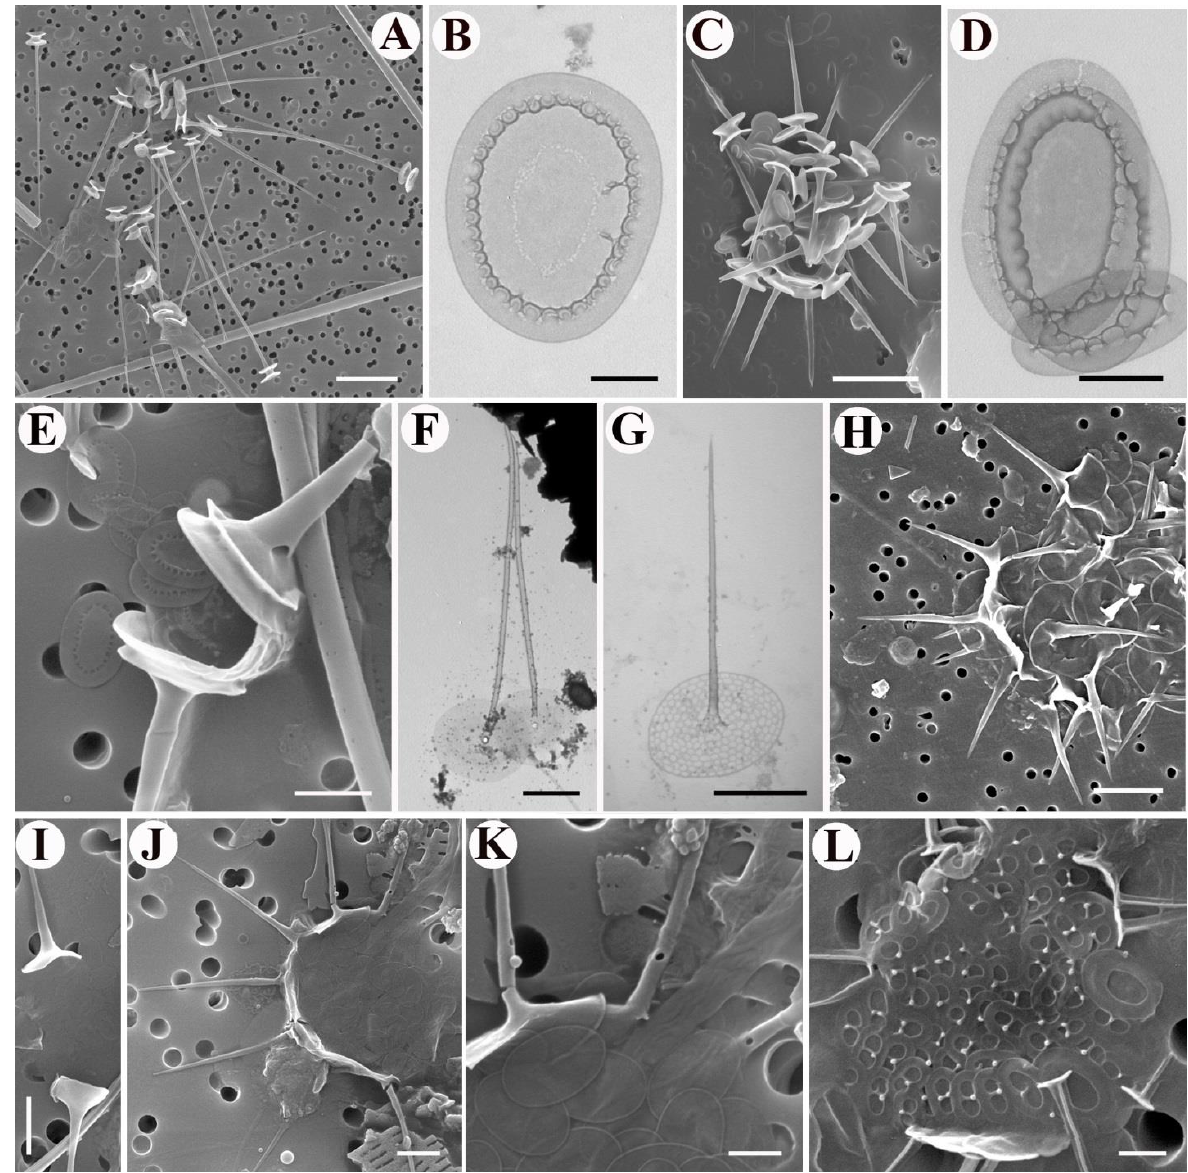
Fig. 2. SEM (A, C, E, H-L), TEM (B, D, F, G). Scales and spines of silica-scaled chrysophytes of Lake